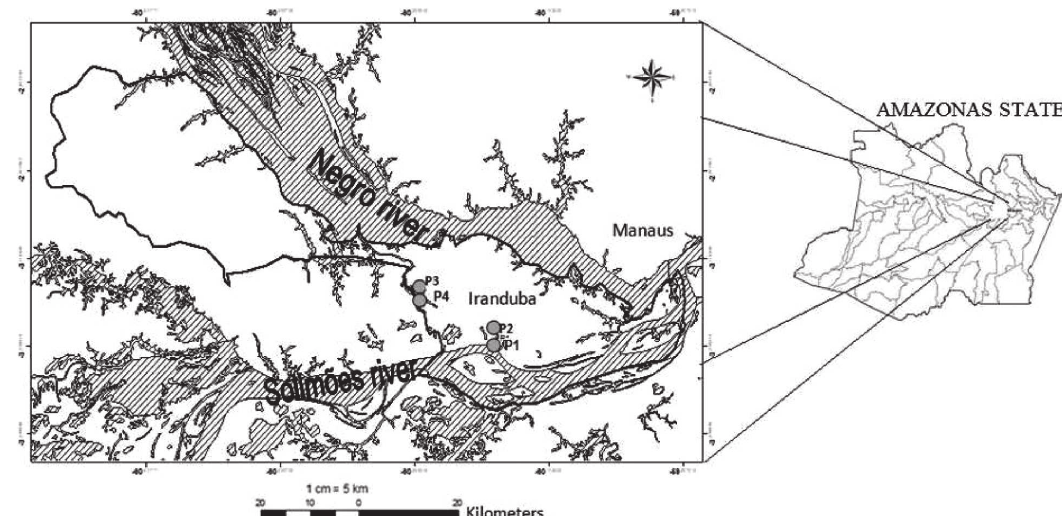
Figure 1. The four geographic locations of the studied soils (P1, P2, P3 and P4) in Iranduba in the State of Amazonas: P1, Plinthic Vetic Ferralsol (Latossolo Amarelo distrófico petroplíntico); P2 and P3, Vetic Endopetric Plinthosol (Plintossolo Pétrico concrecionário típico); P4, Haplic Plinthosol (Plintossolo Háplico alítico